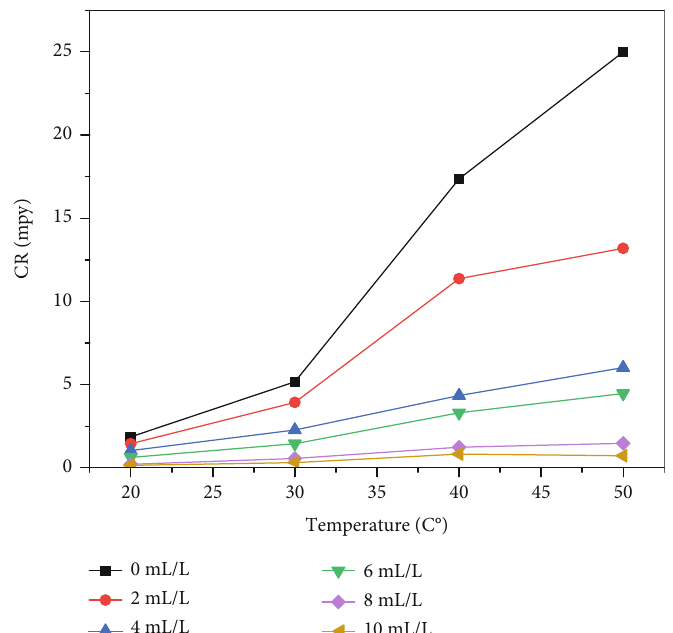
Figure 2: Temperature ’ s e ff ect on corrosion rate of aluminium after immersion in 1M hydrochloric acid for 3hr at di ff erent concentrations of inhibitor.